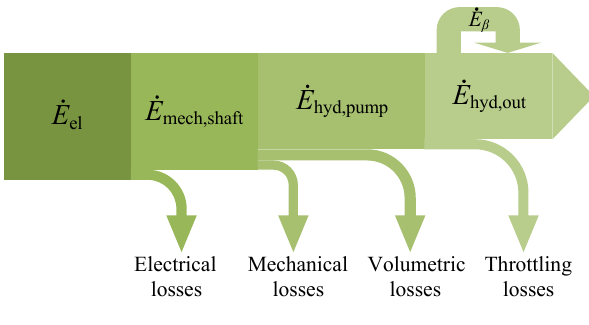
Figure 6: Main losses during operating of the SvSDP- actuated